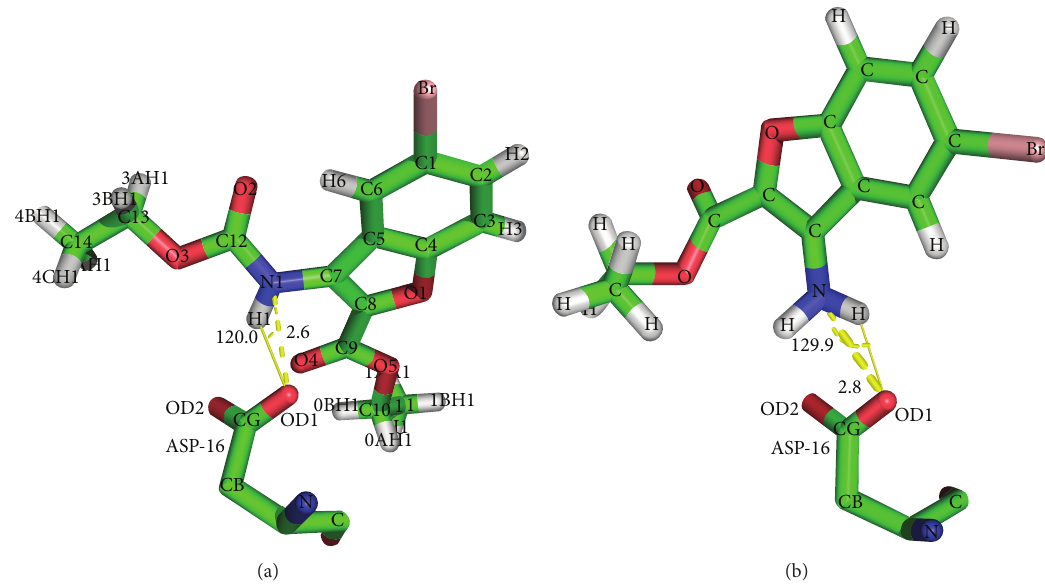
Figure 5: N-H ⋅ ⋅ ⋅ O intermolecular hydrogen bonding of C6 (a) and C7 (b) compared with crystal packing.